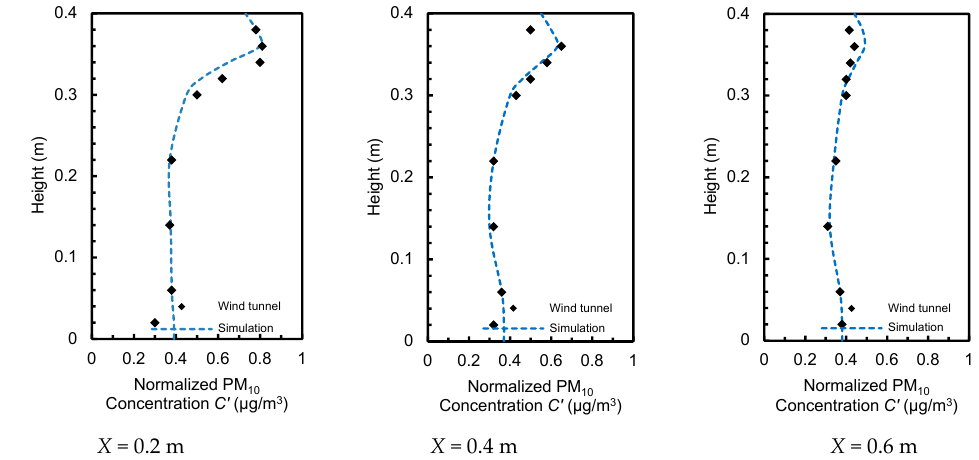
Figure 5. Comparison of normalized PM 10 concentrations in simulations and experiments at three lines ( x = 0.2, 0.4, and 0.6 m). C’ = C x /C in , C x is the concentration at the three lines, C in is the concentration added at the inlet boundary.